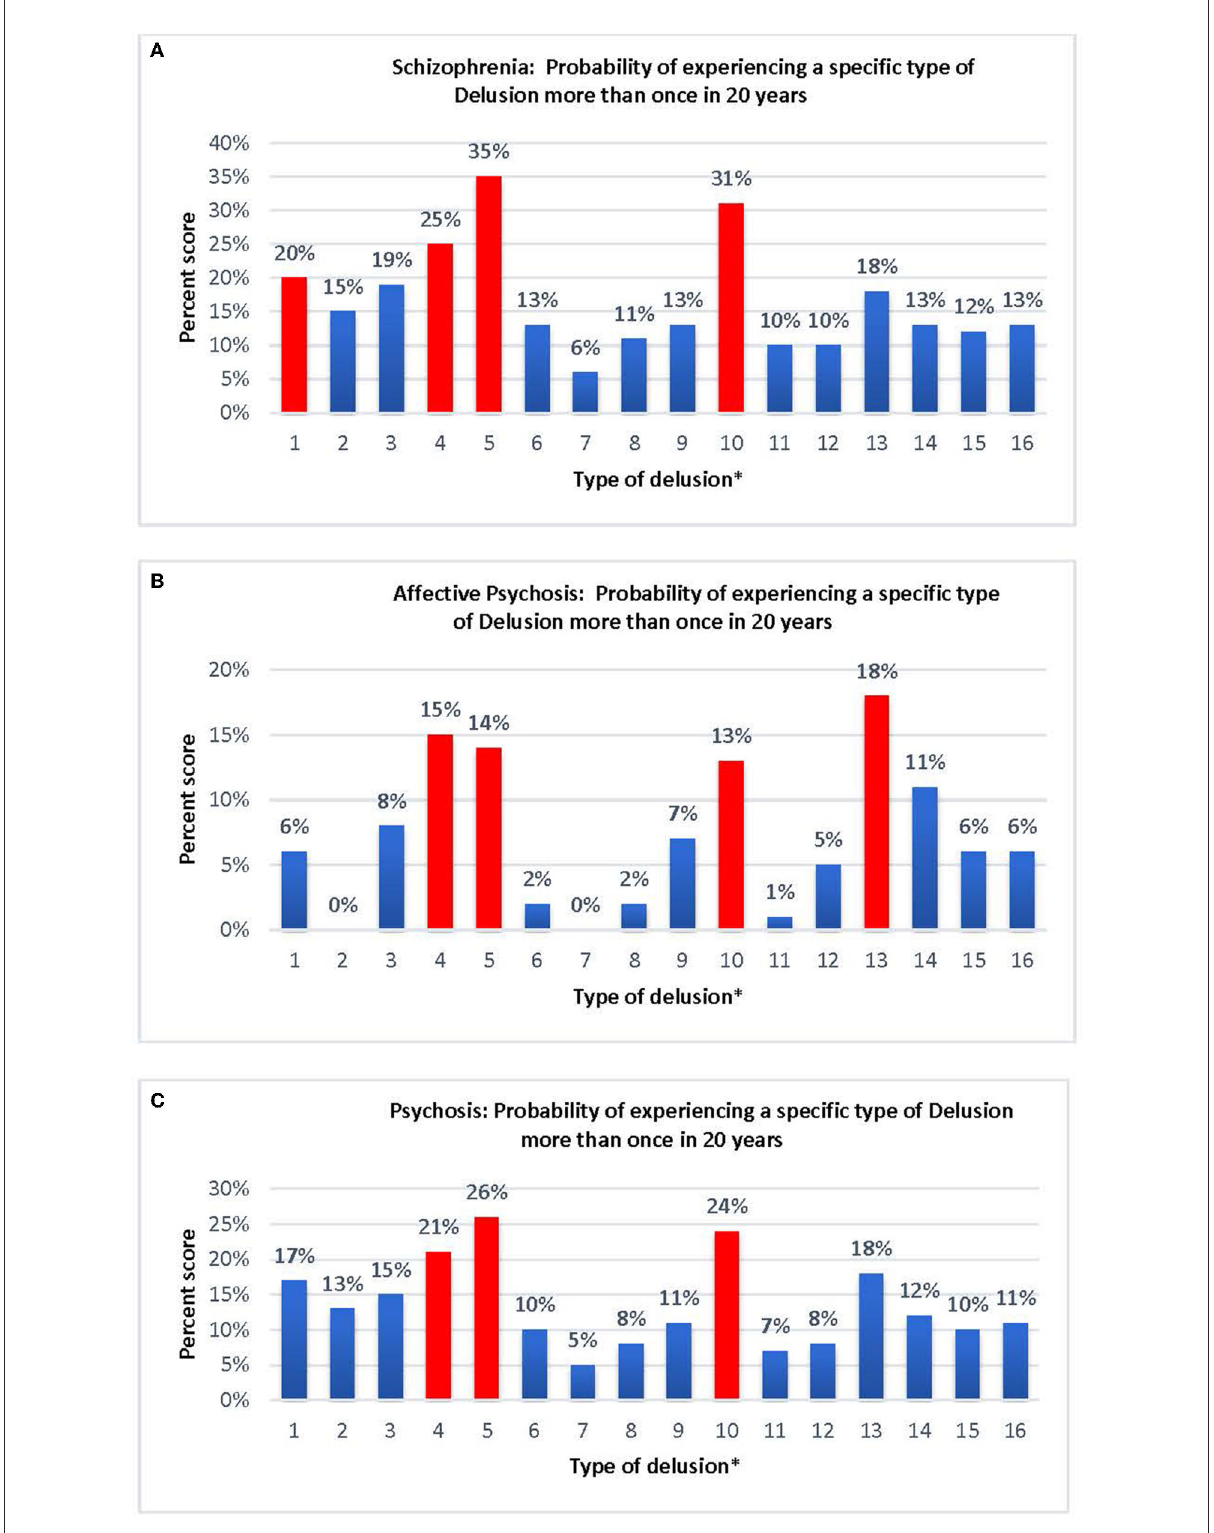
FIGURE1 (A) Schizophrenia: probability of experiencing a specific type of Delusion more than once in 20 years. (B) Affective Psychosis: likelihood of experiencing a specific type of Delusion more than once in 20 years. (C) Psychosis: probability of experiencing a specific type of Delusion more than once in 20 years. [ * Type of delusion: (1) Thought insertion; (2) Thought withdrawal; (3) Thought broadcast; (4) Thought dissemination; (5) Referential; (6) “Made” feelings; (7) “Made” impulse; (8) “Made” volition; (9) Somatic; (10) Persecutory; (11) Self-deprecation; (12) Nihilistic; (13) Grandeur; (14) Religious; (15) Fantastic; (16)